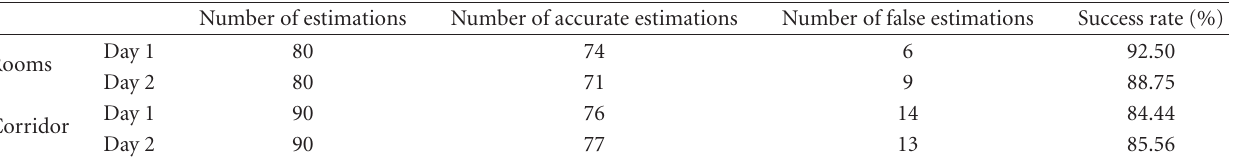
Table 4: Localization precision of WifiLOC positioning system.